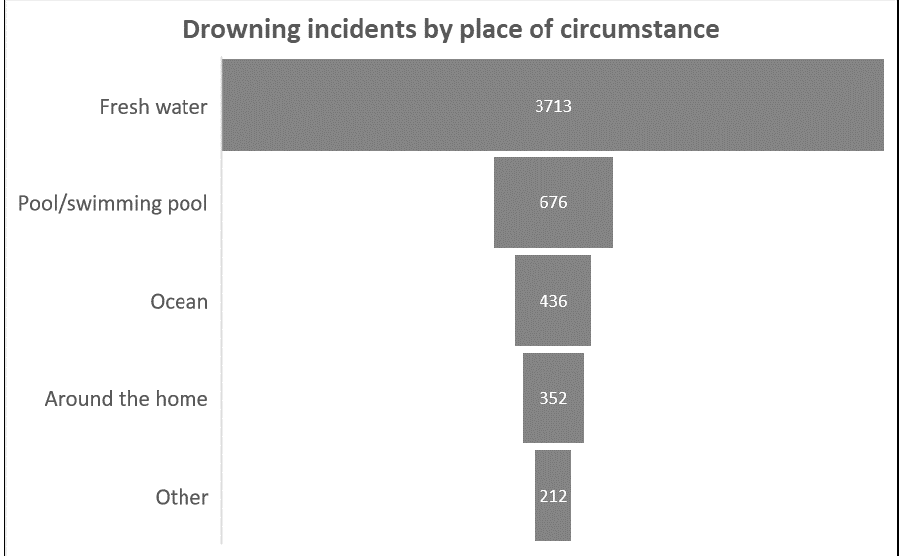
Figure 2. Drowning incidence by place of circumstance in South Africa, 2016–2021. During the month of January, the number of fatal drownings was recorded as 1171, whereas February recorded 931 and November recorded 882. Sundays were the day of the week when fatal drownings ( n = 1591) occurred more frequently, followed by Saturdays ( n = 1503). Fatal drownings have been most frequently reported as occurring between 16:00 and 19:59 ( n =